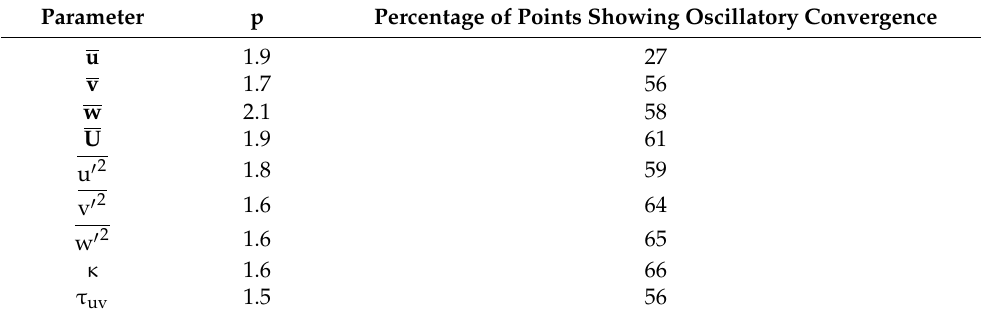
Table 2. Average apparent order of the method, p, and percentage of points showing oscillatory con-